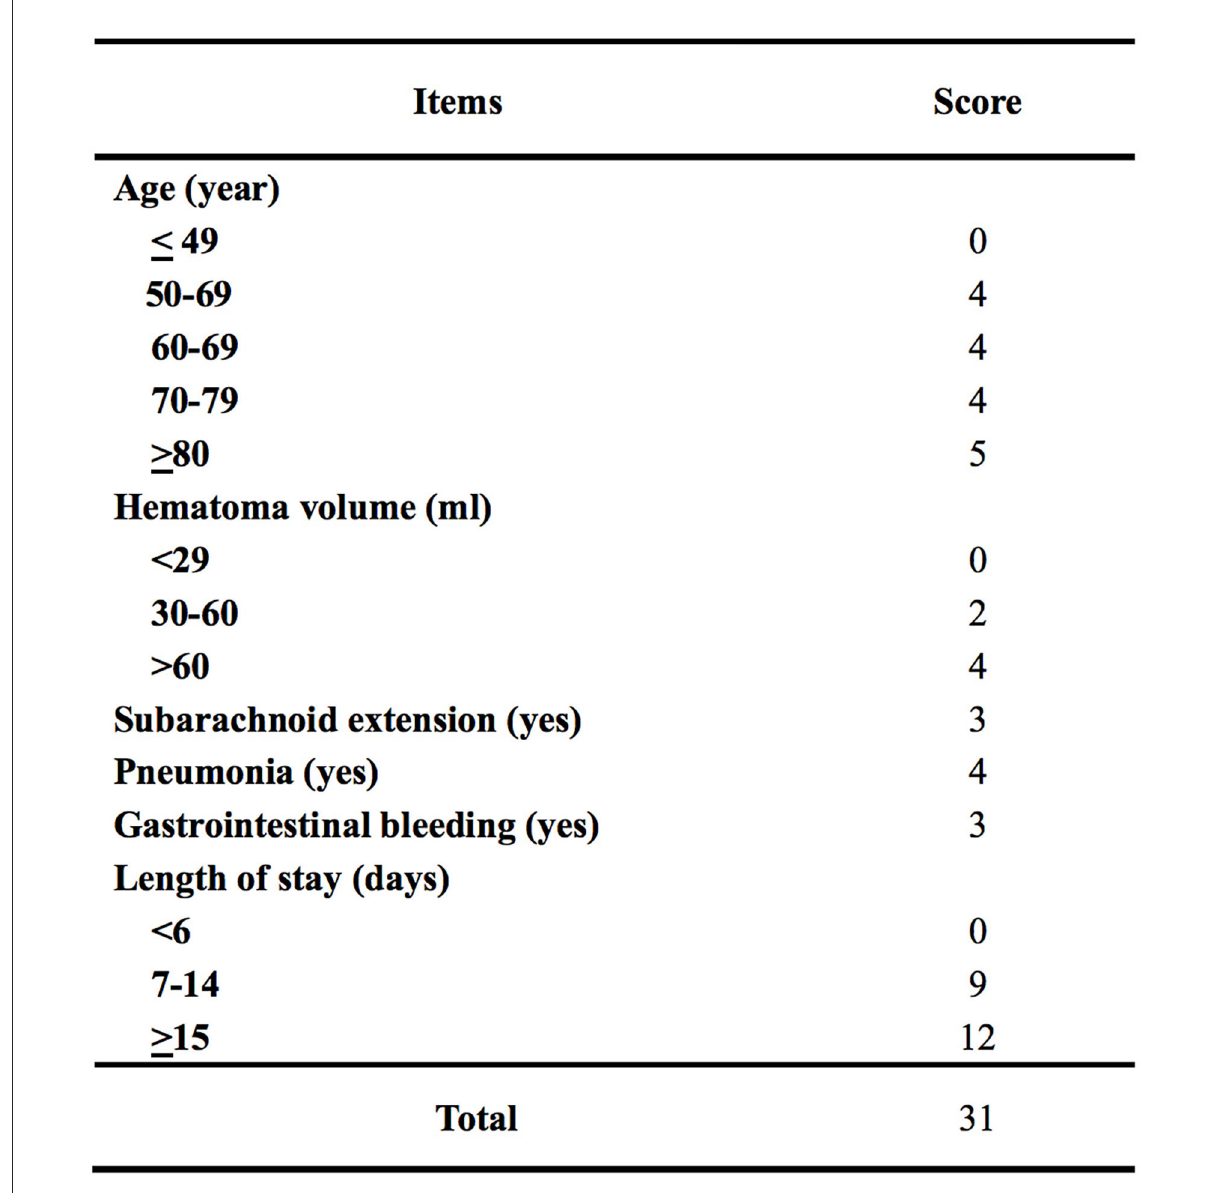
FIGURE1 Scoring system of intracerebral hemorrhage-associated deep vein thrombosis score (the ICH-DVT